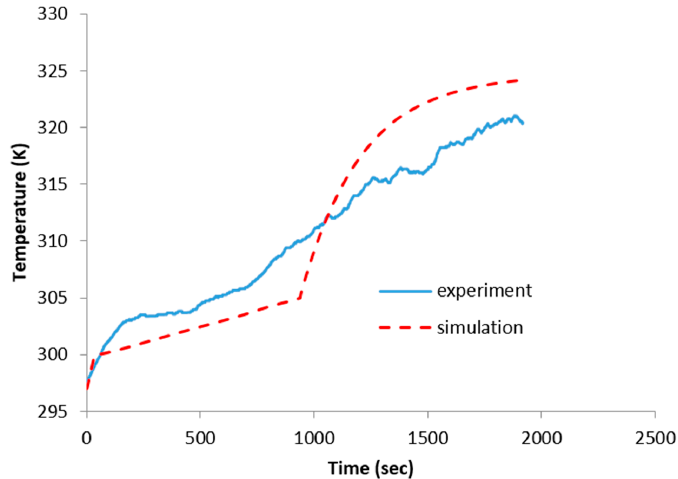
Figure 13. Variation of the heat sink temperature with PCM under a flux of 1250 W/m 2 .